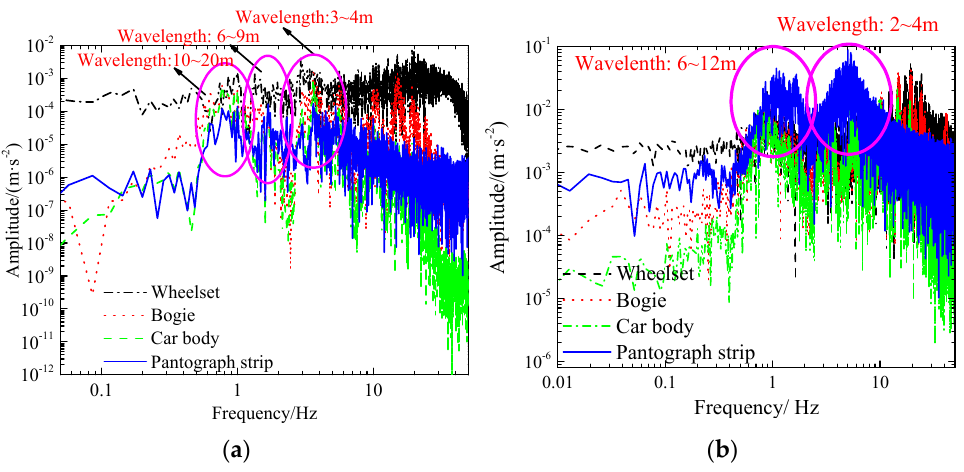
Figure 8. Vibration responses of the vehicle system at 42 km/h: ( a ) vertical responses; ( b ) lateral re- sponses.